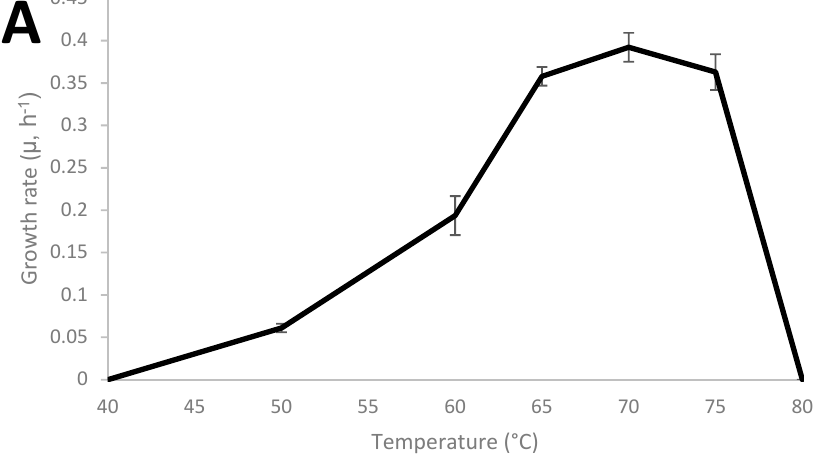
Temperature (°C) Figure 1. Cont